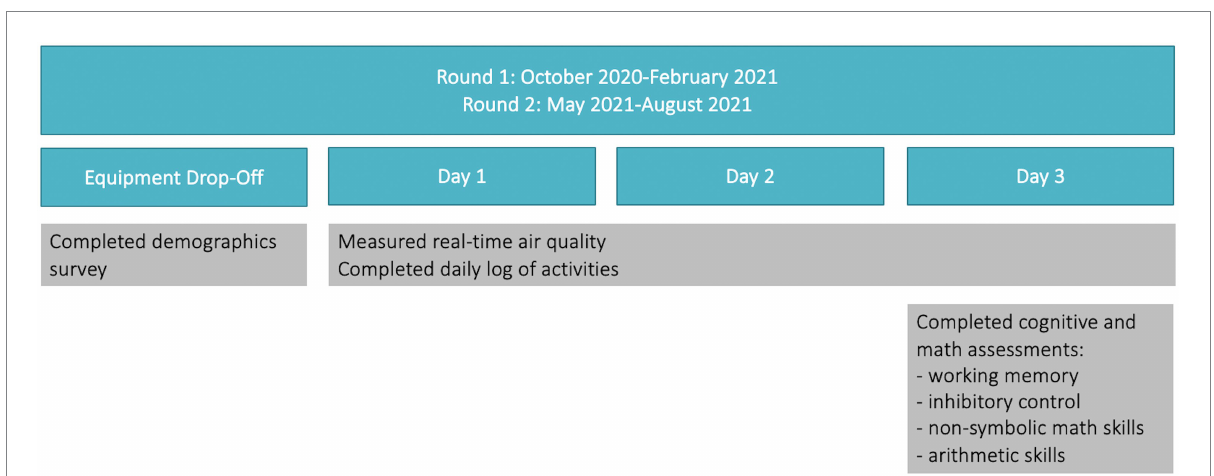
FIGURE 1 Procedure. Participants completed two rounds. Each round had the same procedure. At equipment drop-off, parents completed a demographics survey, after which the child participants wore the Flow device for 3 days. At Day 3, they completed cognitive and math